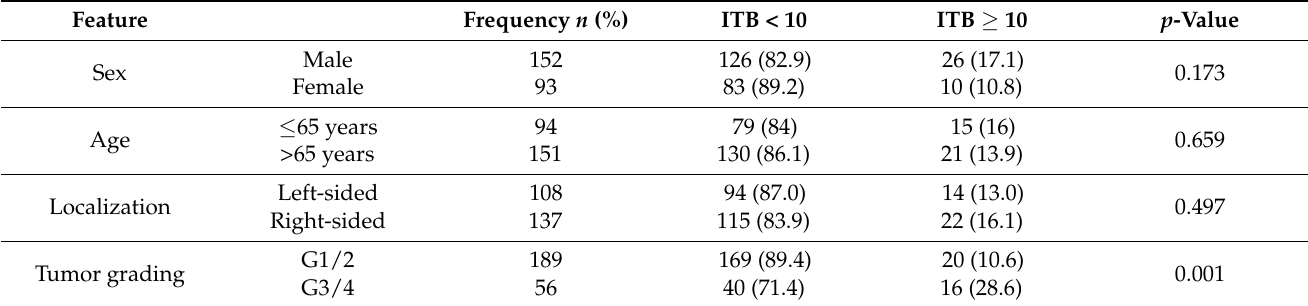
Table 1. Patient characteristics and associations with tumor budding score, n =